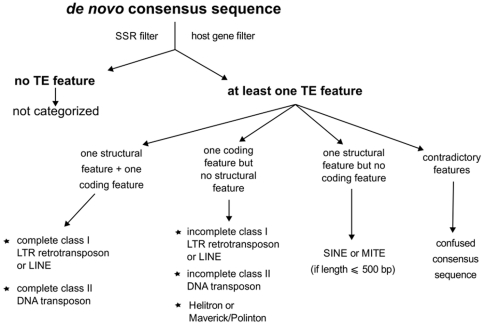
Simplified decision tree implemented in the TE classifier.